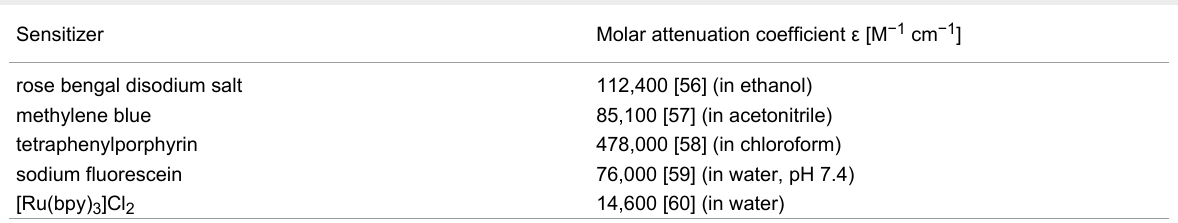
Table 1: Molar attenuation coefficients of common photosensitizers a (bpy = 2,2‘-bipyridine).